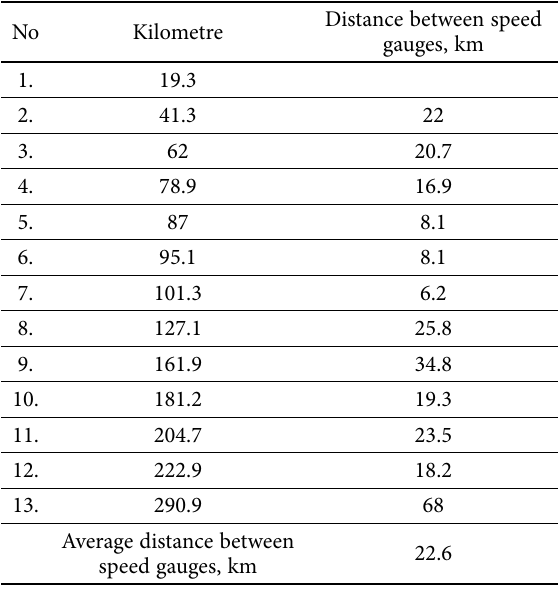
Table 6. The percentage of traffic accidents that occurred